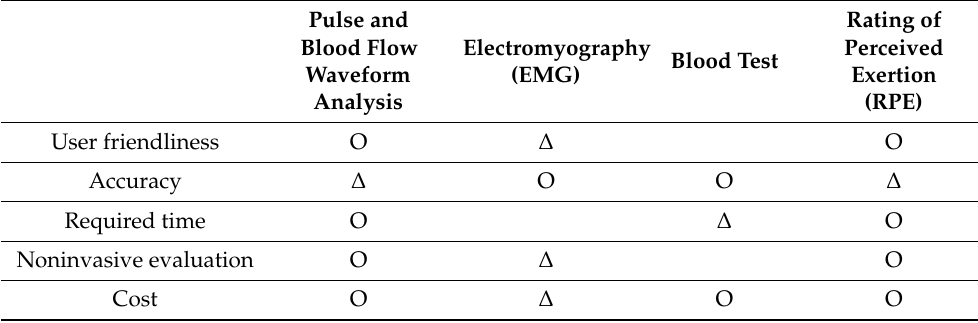
Table 2. Comparison of different methods for evaluating physiological effects of running. “O”: good performance; “ ∆ ”: acceptable